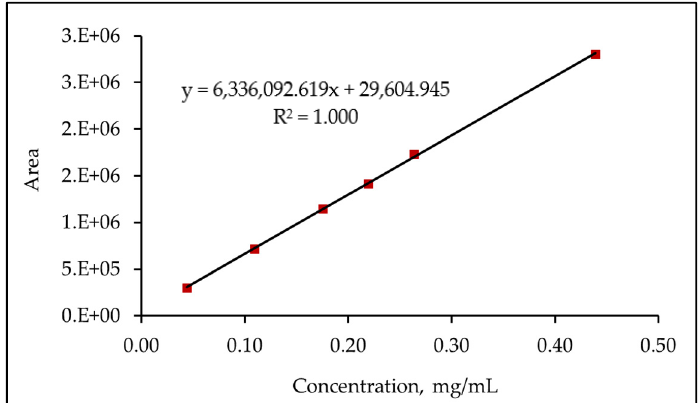
Figure 5. Linearity curve of favipiravir. Table 4. Results of